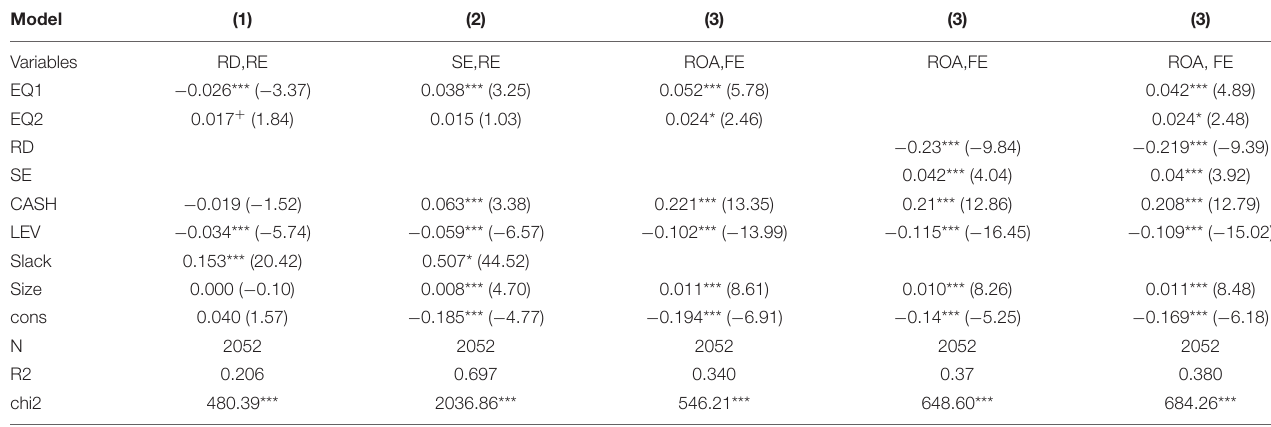
TABLE 3 | Stepwise regression